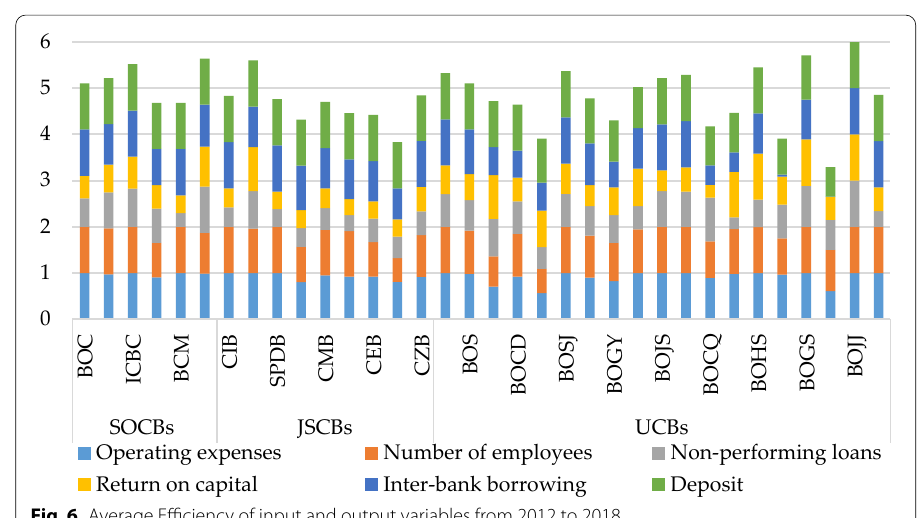
Fig. 6 Average Efficiency of input and output variables from 2012 to